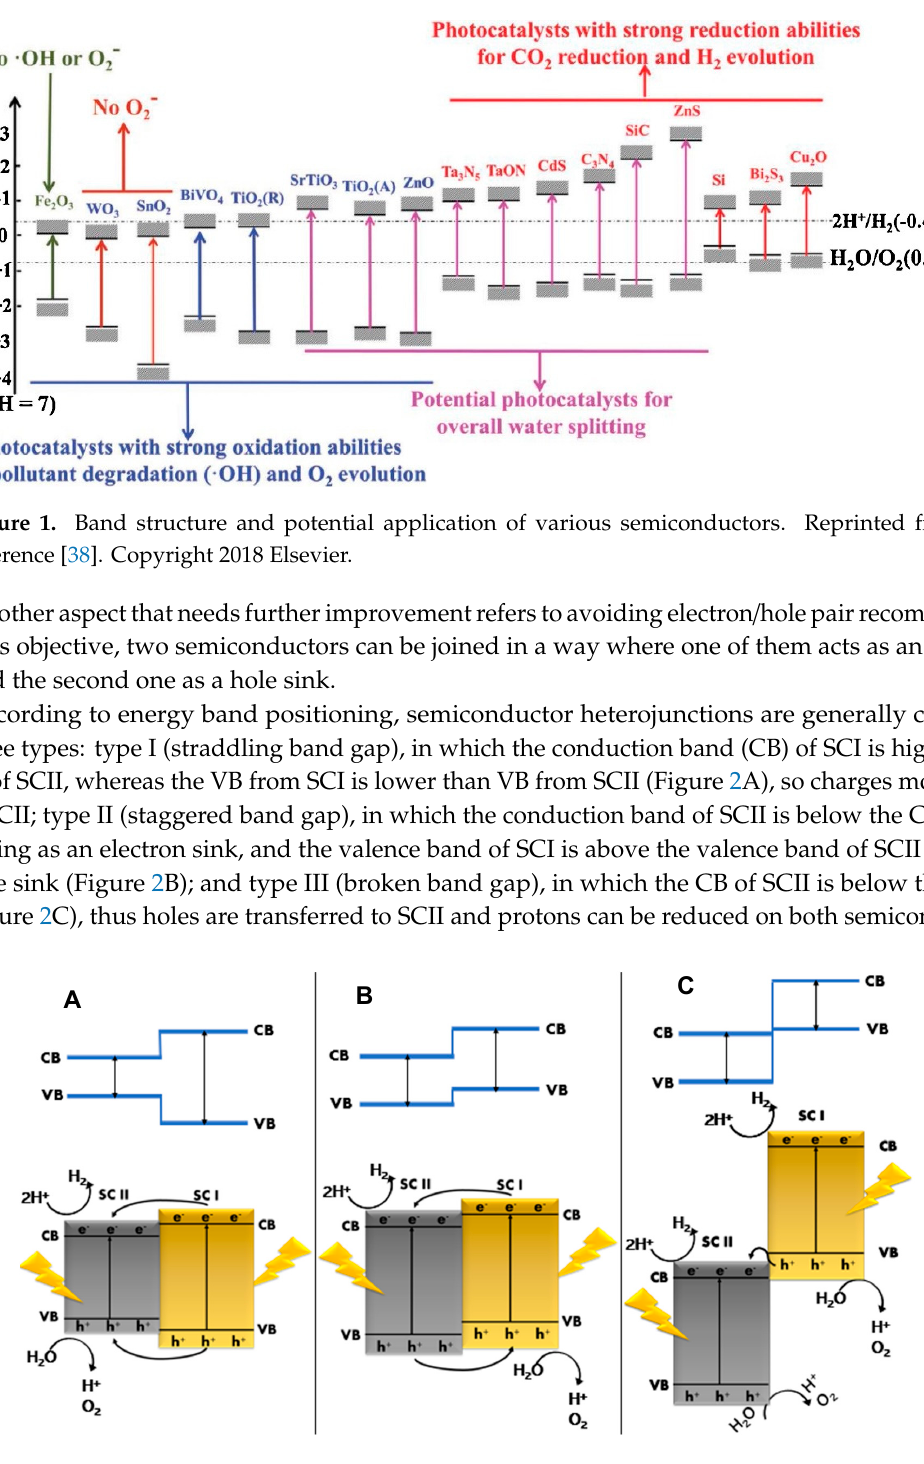
Figure 2. Classification of semiconductor heterostructures according to band position: ( A ) type I heterojunction; ( B ) type II heterojunction; ( C ) type III